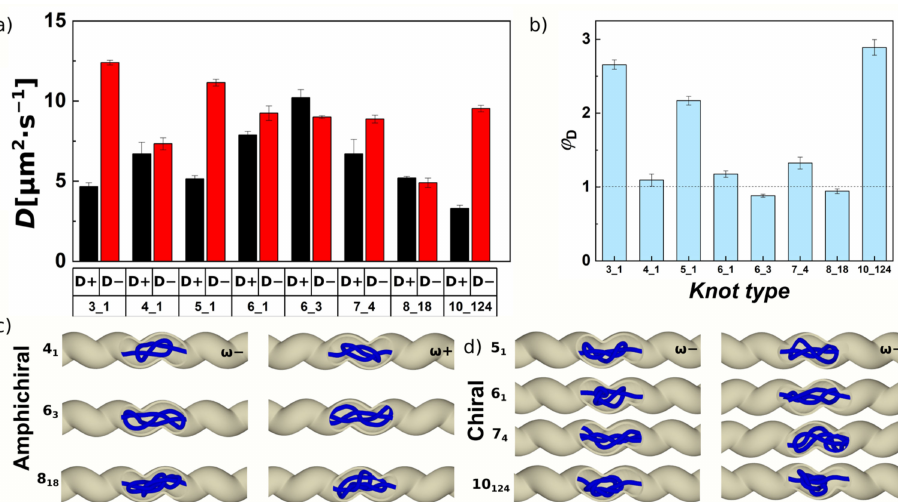
Figure 5. Stereoselectivity of helical channels ( R H = 1 σ ) for different knot types. ( a ) Diffusivities of grouped enantiomers of different knot types in helical confinement. For amphichiral knots (4 1 , 6 3 and 8 18 ), we flipped handedness of the channel rather than writhe of the knot. ( b ) Magnitude of the stereoselectivity of the helical channel expressed as ϕ D = D = / D ± . The dashed line indicates no selectivity. ( c ) Snapshots from simulations showing the situation of the knotted portions in helical channels for amphichiral system with righthanded ( left ) and lefthanded helical channel ( right ). ( d ) Snapshots from simulations showing the situation of the knotted portions in helical channels for chiral knots, with equichiral ( left ) and antichiral ( right ) placement of knots in righthanded helical channel. The handedness of the channels is indicated by ω + and ω −